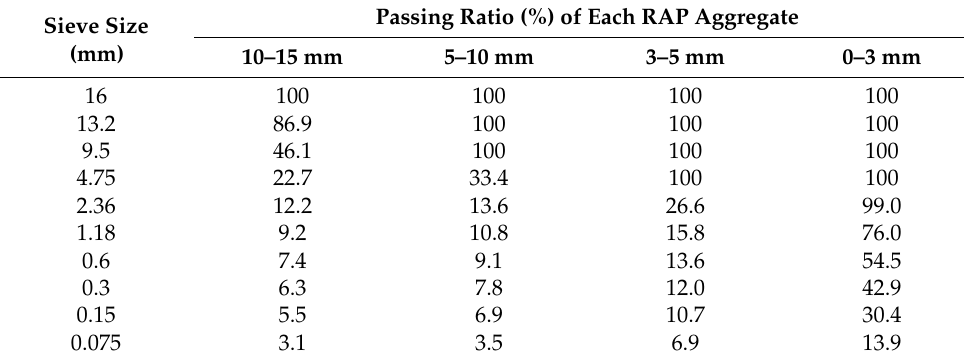
Table 2. Particle size distribution of each RAP class.